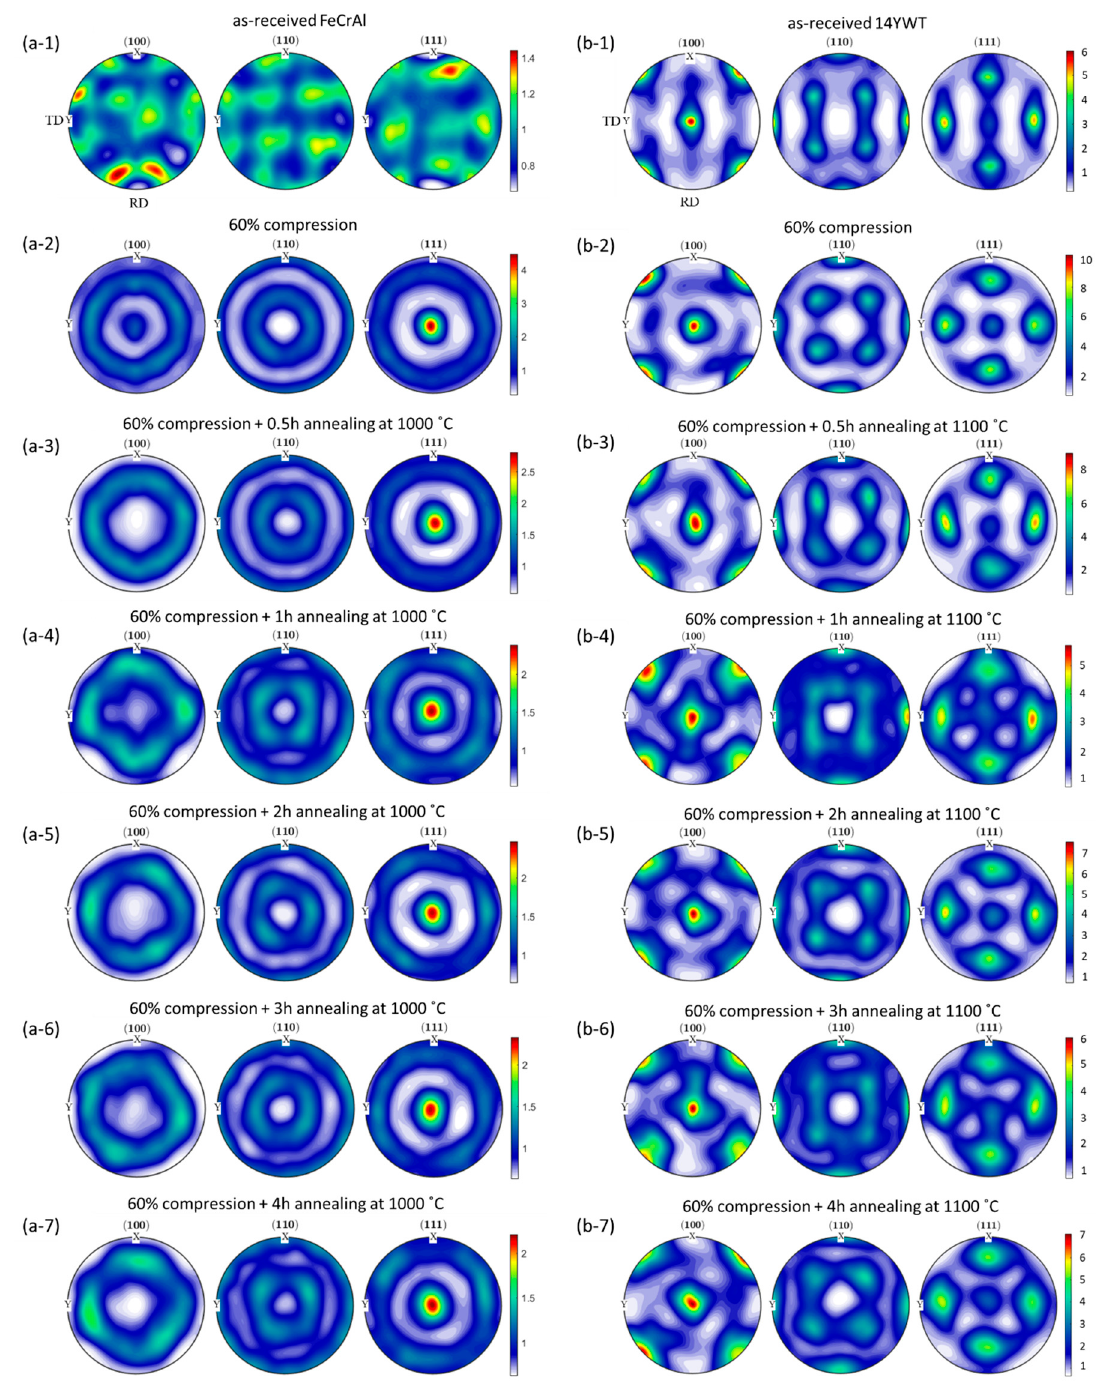
Figure 2. Pole figures showing the evolution of the texture after deforming to 60% and annealing (( a-1 ) to ( a-7 )) at 1000 °C for up to 4 h in the FeCrAl alloy, and (( b-1 ) to ( b-7 )) at 1100 °C up to 4 h in the 14YWT alloy.